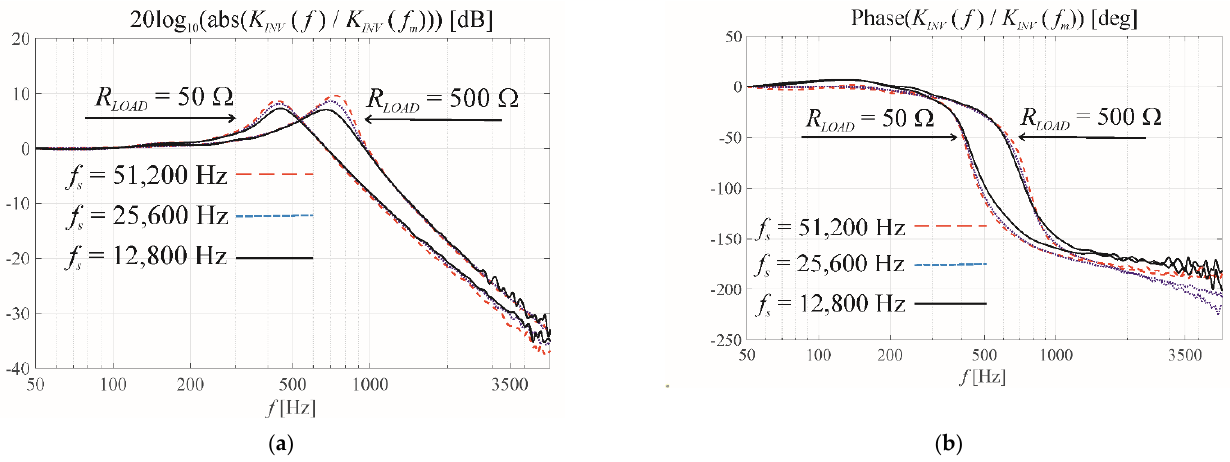
Figure 8. Bode magnitude ( a ) and phase ( b ) plots for f s = 12,800 Hz, 25,600 Hz, and 51,200 Hz, and two loads—50 and 500 Ω .